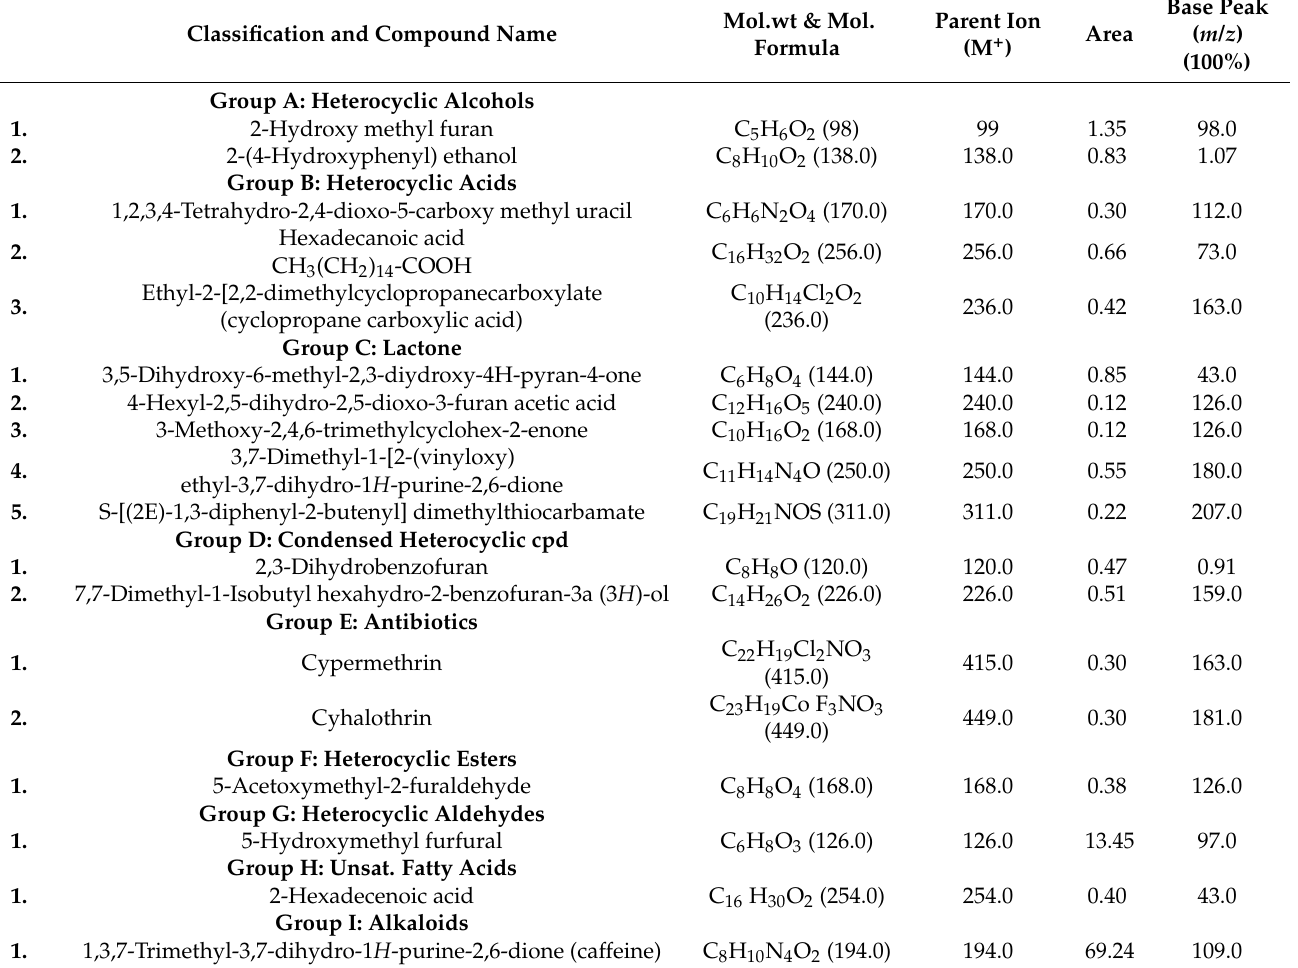
Table 1. Putative identification of the chemical components from KFB when subjected to GC-MS (gas liquid chromatographic– mass